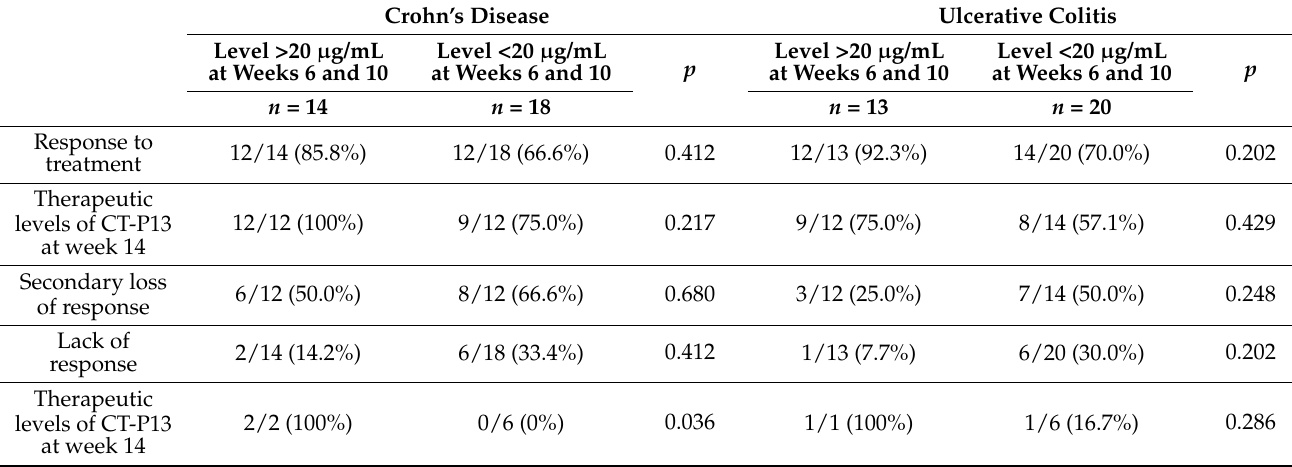
Table 6. CT-P13 levels >20 µ g/mL and < 20 µ g/mL at weeks 6 and 10 in patients with CD and UC and response to